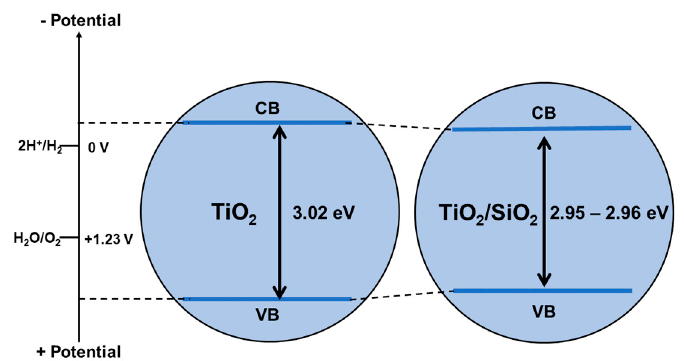
Figure 6. The proposed bandgap of the TiO 2 /SiO 2 composite and the potential levels of CB (conduc- tion band) and VB (valence band) (vs. NHE).